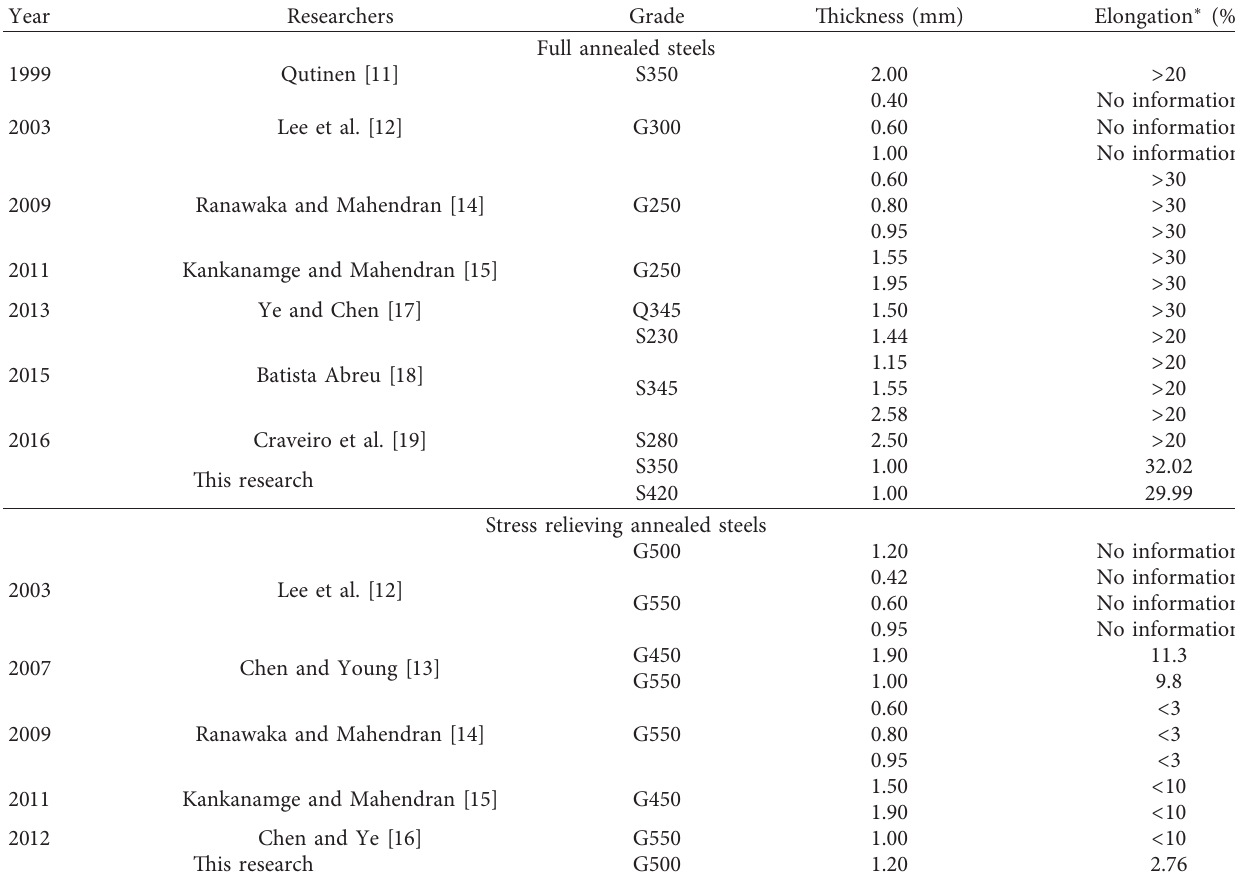
Table 7: Compilations of basic information for current test data.